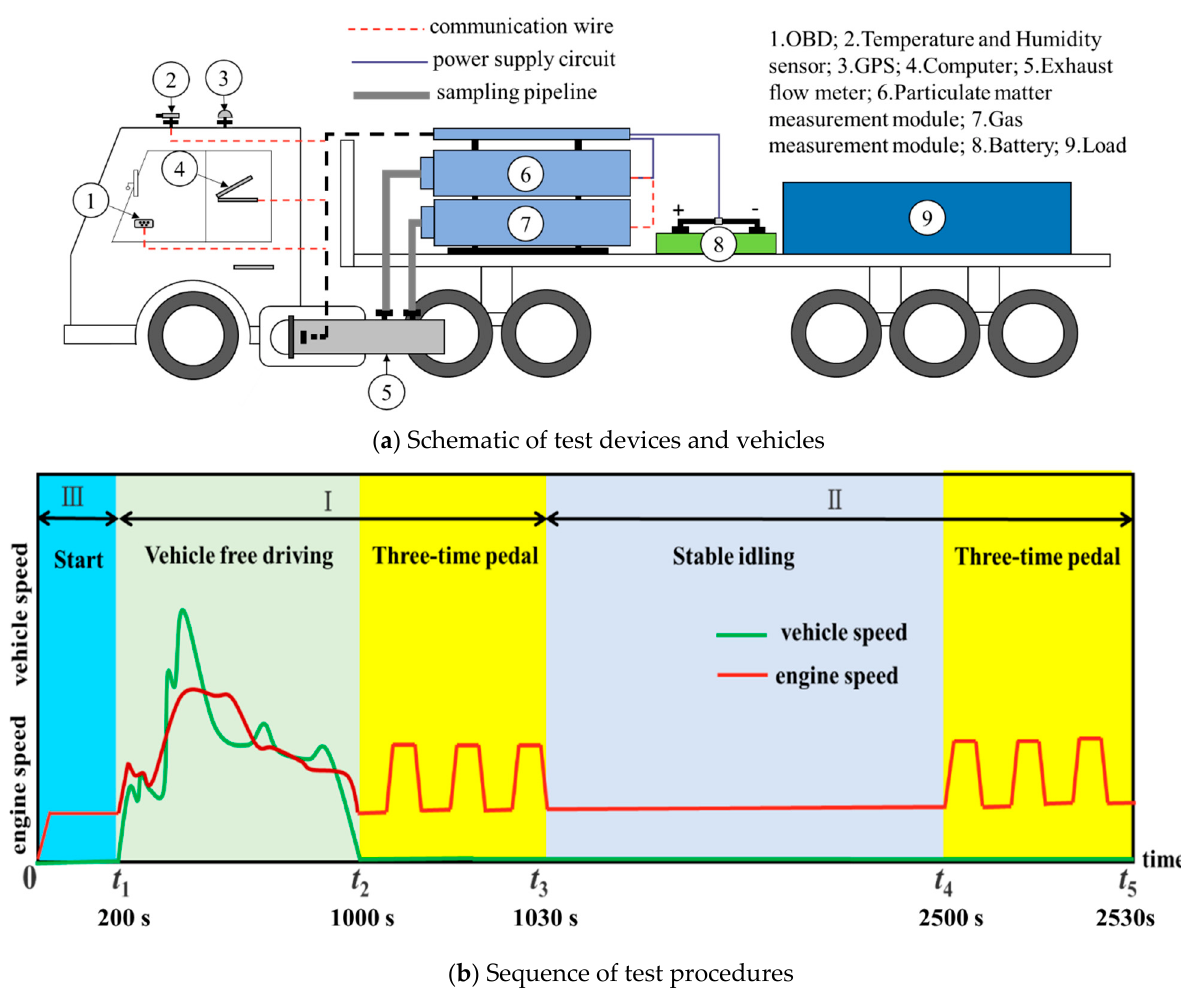
Figure 2. Test devices and test procedures.